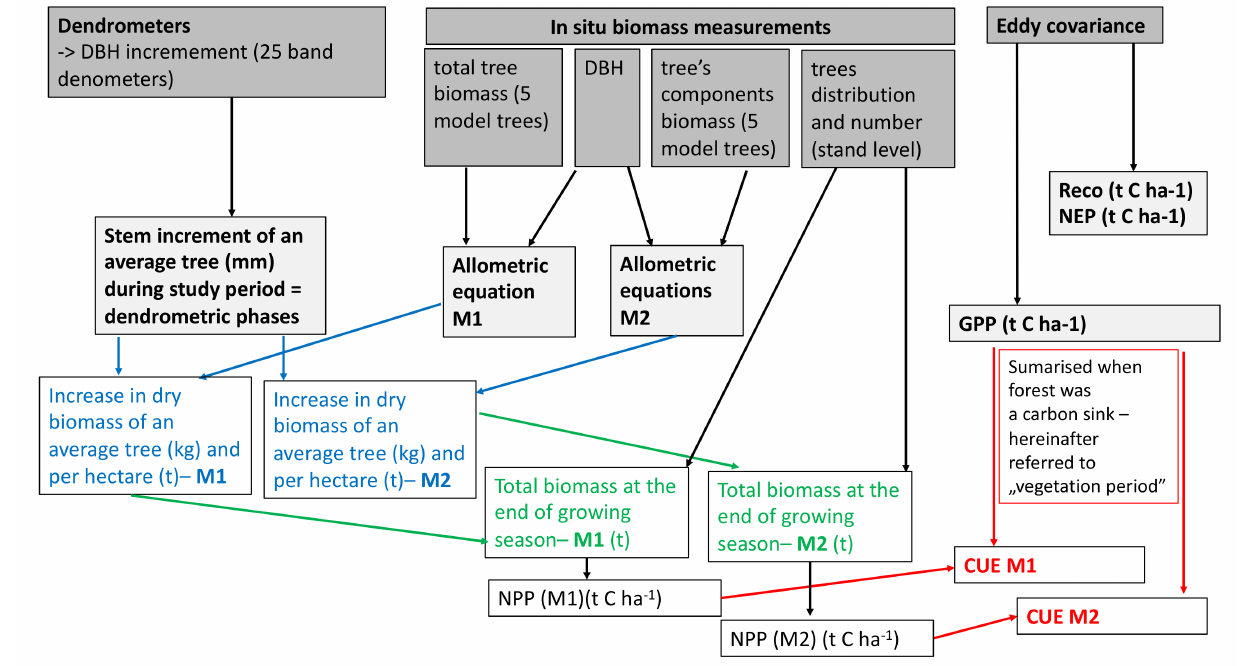
Figure 4. Schematic of data analysis and calculation combining results from dendrometric, biometric and EC measurements for obtaining net primary productivity (NPP), gross primary productivity (GPP) and carbon use efficiency